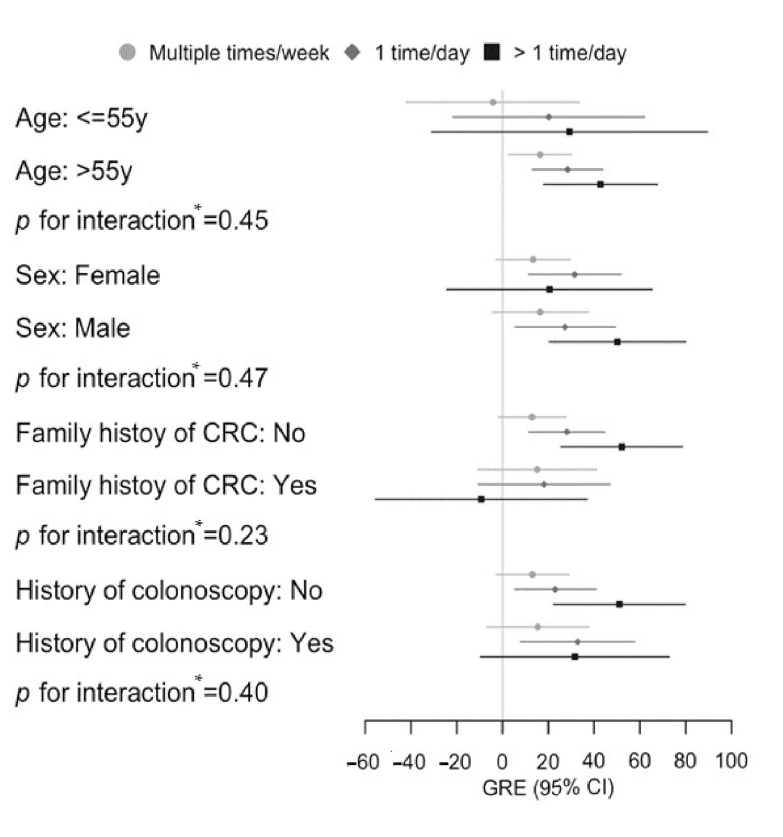
Figure 2. Genetic risk equivalents for comparisons between red and processed meat intake categories in different subgroups. * Interactions were tested by additionally including the multiplicative term of stratification factors (age, sex, family history of CRC, or history of colonoscopy) and red and processed meat intake in the multivariable models, but with a polygenic risk score included as percentiles (per 10 percentiles, continuous variable). Participants who consumed red and processed meat ≤ 1 time/week were used as reference in each subgroup. Abbreviations: CI, confidence interval; CRC, colorectal cancer; GRE, genetic risk